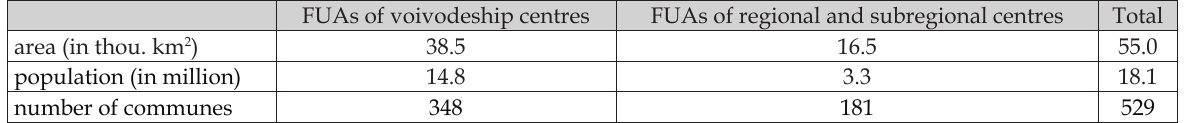
Table 3. Area, population and number of communes implementing ITIs in Poland.